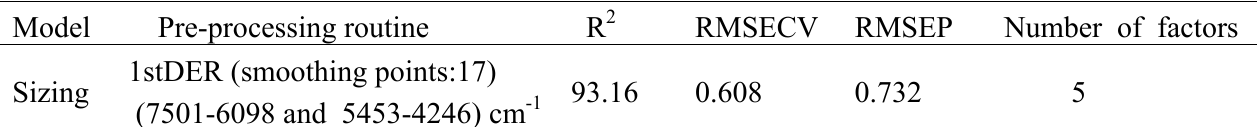
Table 2. R 2 , RMSECV, RMSEP and number of factors for the sizing models using different pre- processing